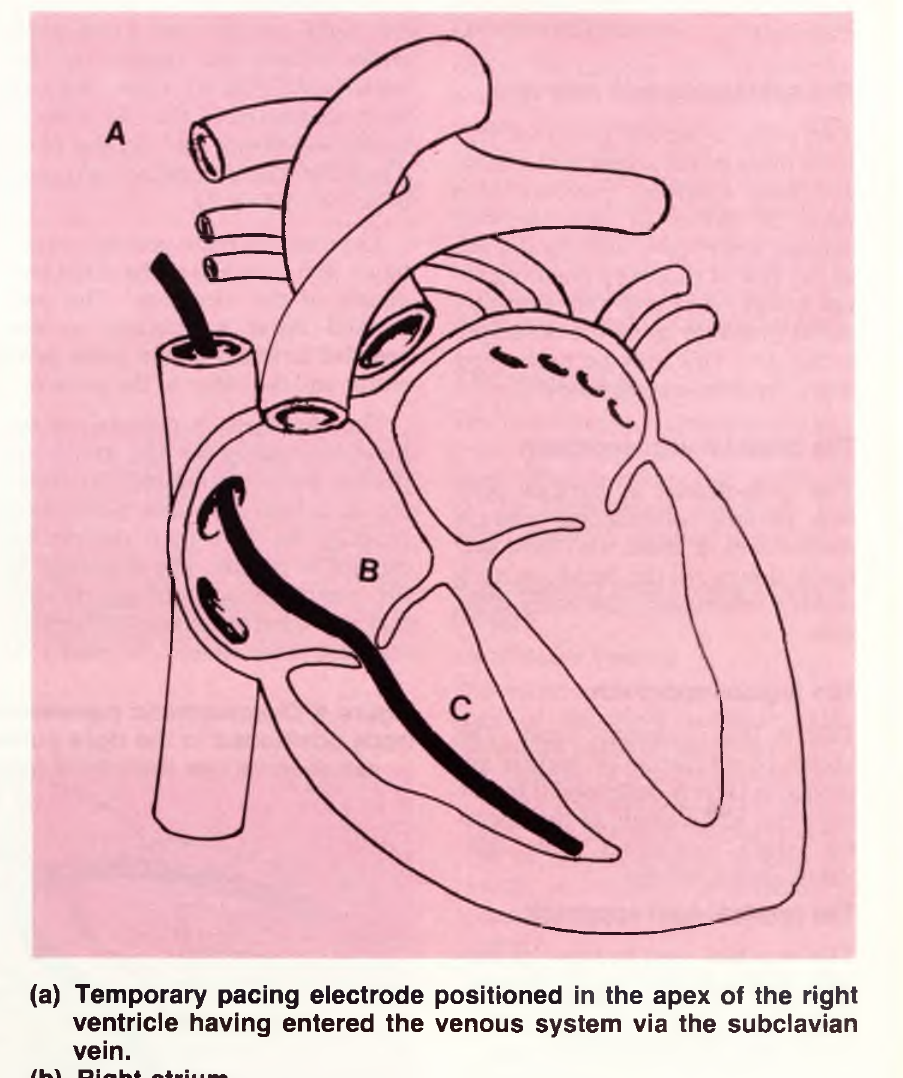
Figure 7: Diagrammatic representation of a temporary pacing elec­ trode positioned in the apex of the right